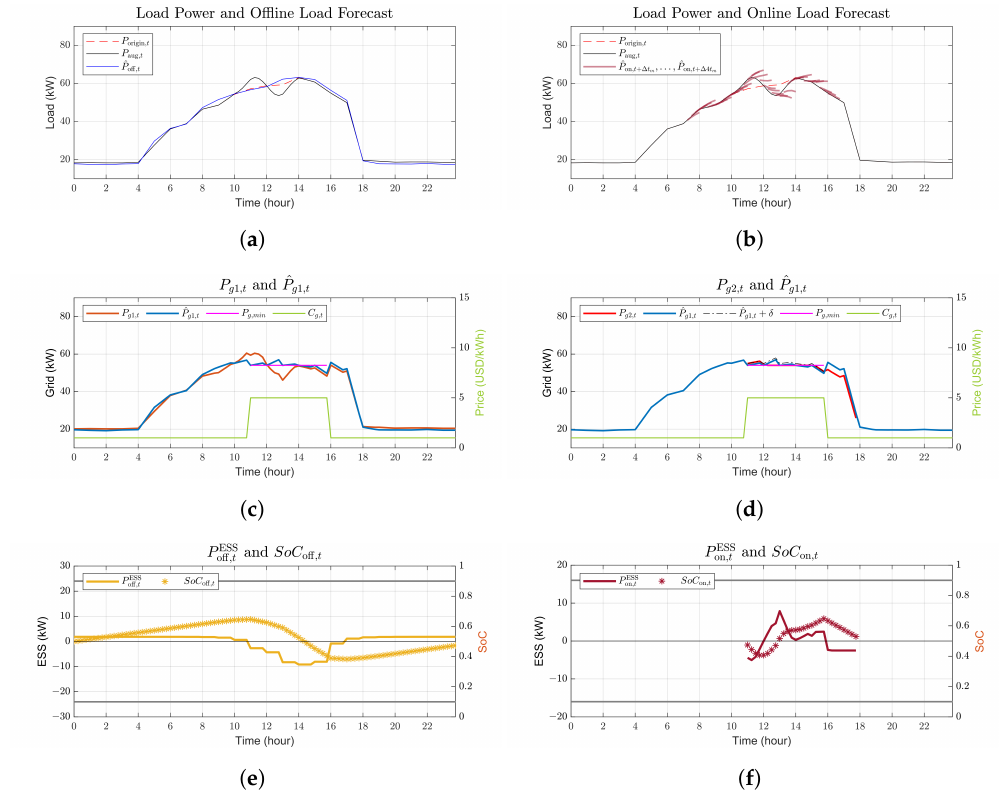
Figure 13. Offline ESS scheduling and online ESS operations with indefinite synthetic uncertainties. ( a ) Offline load forecast, ( b ) Online load forecast, ( c ) The estimated power ˆ P g 1, t and real power P g 1, t from the main grid by using only ESS off , ( d ) The estimated power ˆ P g 1, t and real power P g 2, t from the main grid by using both ESS off and ESS on , ( e ) The amount of charging or discharging of ESS off